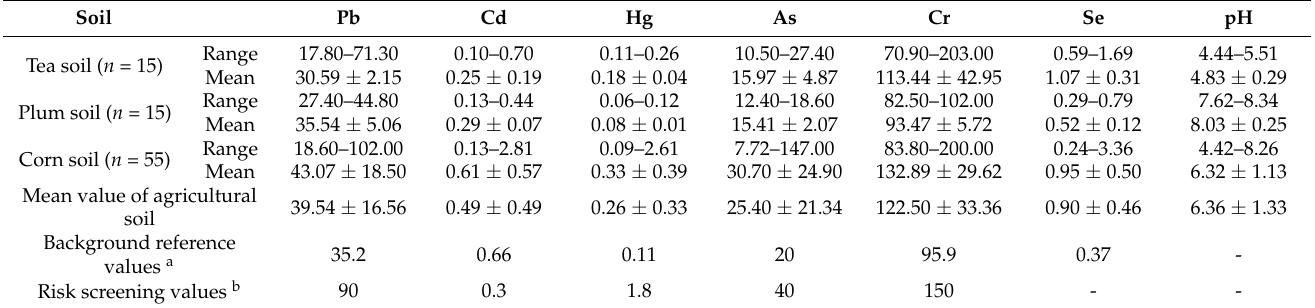
Table 4. Descriptive statistical analysis of HMs concentrations (mg/kg) in agricultural soils in the study